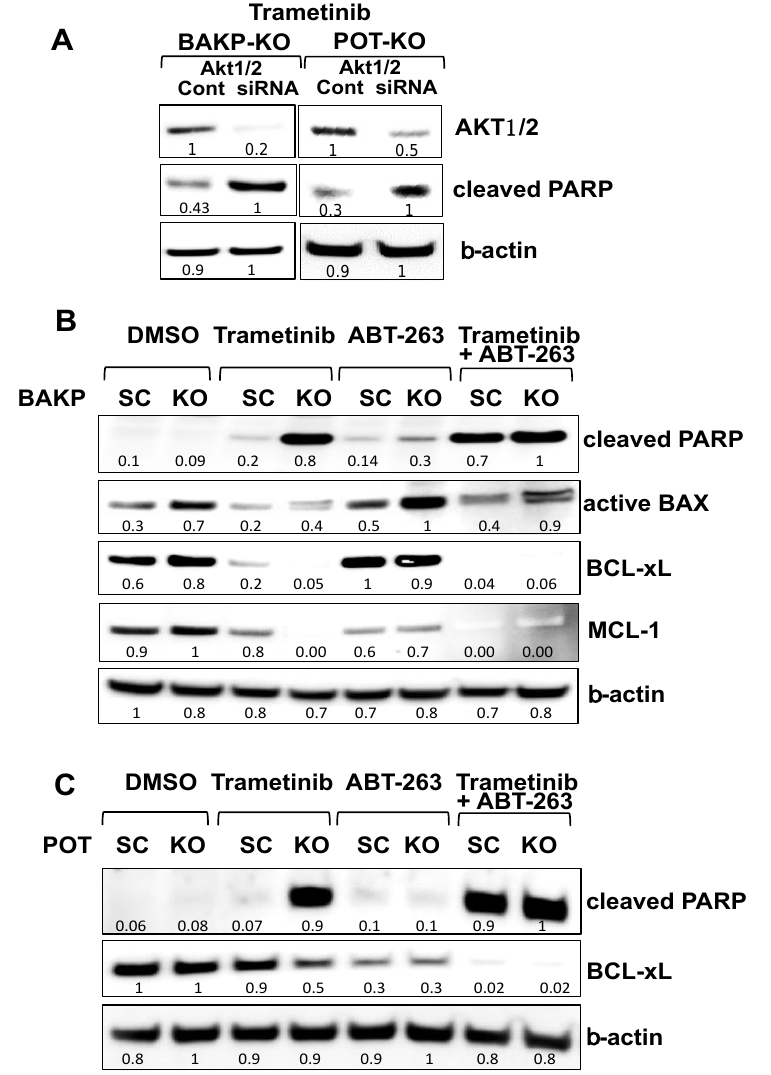
Figure 7. siRNA knockdown of AKT1/2 in BAKP ( A , left panel) and POT cells ( A , right panel), or BCL-2 family inhibitor ABT-263 and/or CD133 knockdown reveals that AKT1/2 siRNA knockdown or BCL-2 family inhibition with ABT-263 plus CD133 knockdown both block the AKT pathway, inducing maximum apoptosis in the presence of trametinib in BAKP ( B ) and POT cells ( C ). ( A ) BAKP-KO and POT-KO cells were transfected with AKT1/2 siRNA pool or the scrambled control siRNA (“Cont”). Then, 48 h after transfection, cells were treated with 100 mM trametinib for 24 h, and subjected to immunoblot analysis with antibodies to AKT1, cleaved PARP, or β -actin. ( B ) BAKP-KO and ( C ) POT-KO cells or their respective controls BAKP-SC and POT-SC cells were treated for 48 h with trametinib (100 nM) or the BCL-2 family inhibitor ABT-263 (100 nM) alone or in combination, and then subjected to immunoblot analysis with antibodies to cleaved PARP, active BAX, BCL-xL, MCL-1, or β -actin. Densitometric analysis comparing intensities of protein bands relative to bands with the highest intensity is shown in immunoblots.